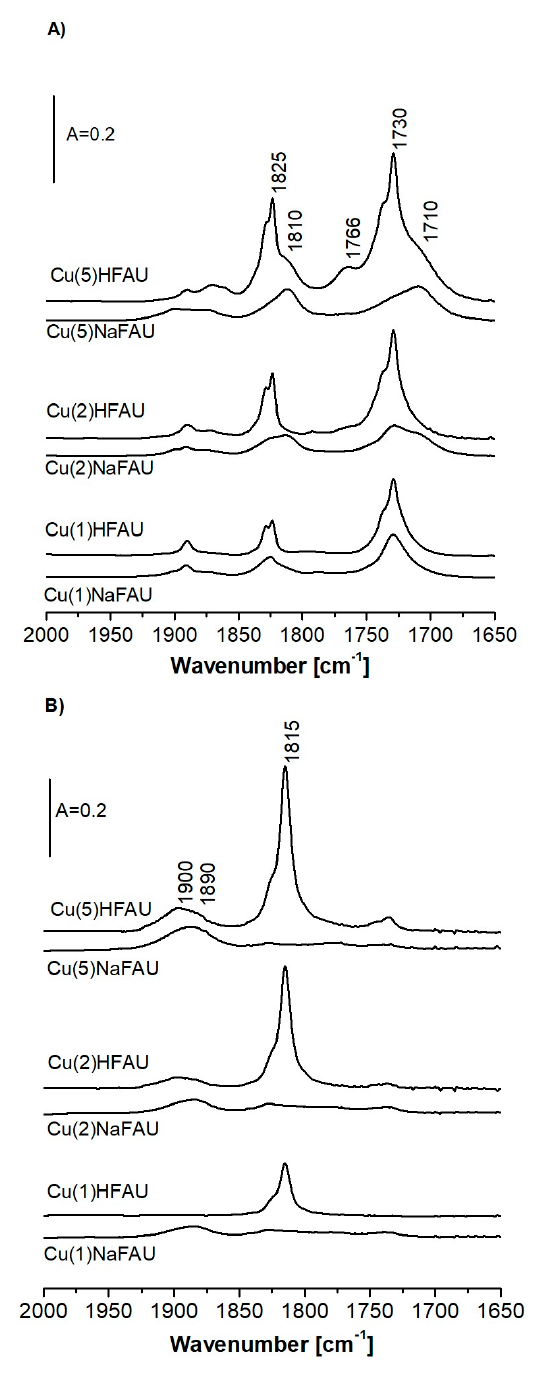
Figure 7. The spectra of NO sorbed at 170 K in zeolites CuHFAU ( A ) and CuNaFAU ( B ) of various Cu contents.